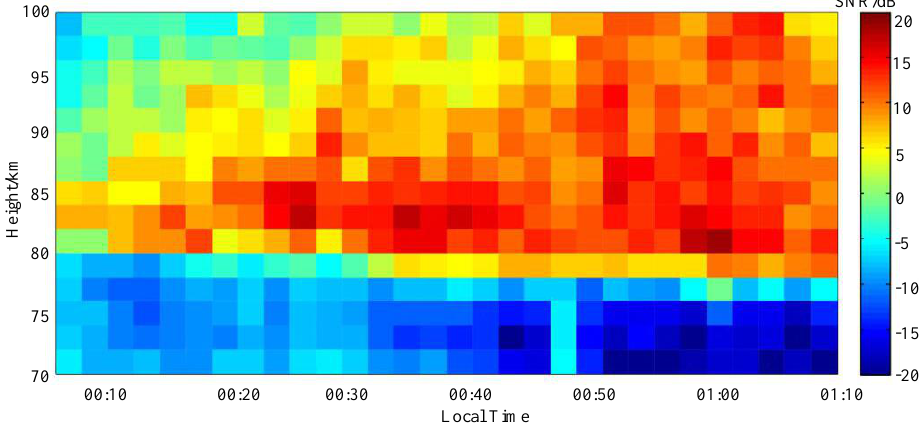
Figure 13. SNR map for mesospheric sounding at the local time of 00:08 − 01:08, 1 January 2018.